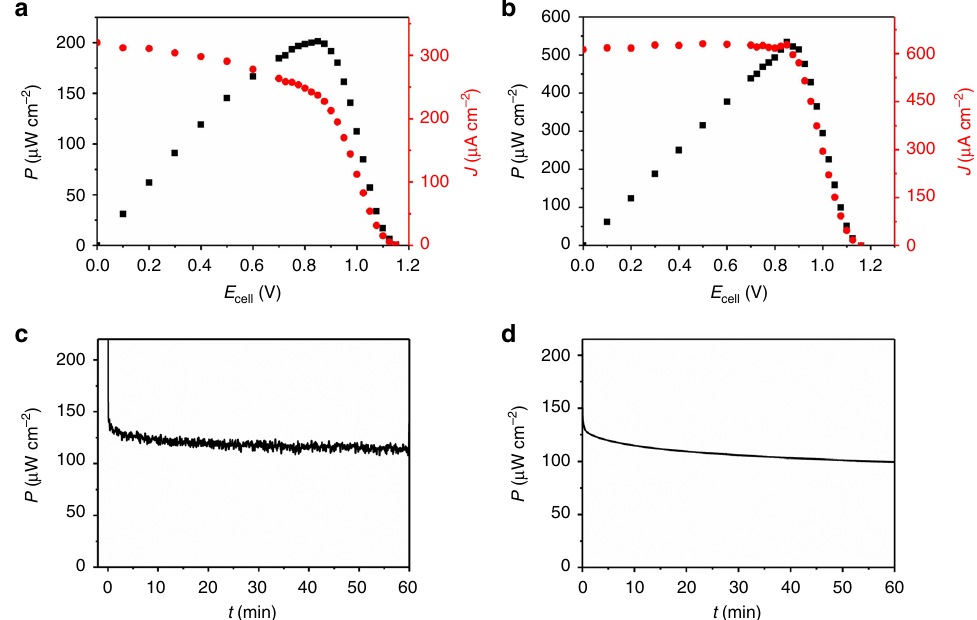
Fig. 5 Characterization of the hydrogen/glucose biofuel cell. Performance ( a , b ) and stability ( c , d ) of the H 2 /glucose(H 2 O 2 )-powered hydrogenase (H 2 ase)/ horseradish peroxidase (HRP)-based biofuel cells in 0.1 M phosphate buffer (pH 7.4) and in a two-compartment cell with the polymer double- layer bioanode (P(N 3 MA-BA-GMA)-vio/H 2 ase//P(SS-GMA-BA)/Py 2 Ox/CAT) and the Py 2 Ox/HRP/CNT/CMF-carbon cloth biocathode. a : H 2 ase = Dv MF-[NiFe], 1 mM glucose in both compartments; OCV = 1.15 V; J = 240 µ A cm − 2 and P max = 200 µ W cm − 2 at 0.85 V. b H 2 ase = Dv H-[NiFeSe], 3 mM glucose in both compartments. OCV = 1.15 V; J = 630 µ A cm − 2 and P max = 530 µ W cm − 2 at 0.85 V. c , d Operational stability at a constant load of 0.8 V of the Dv MF-[NiFe] ( c ) and the Dv H-[NiFeSe] ( d ) based BFC; 3 mM glucose was used in the bioanode and the biocathode compartment. a – d Bioanode compartment = 97% H 2 /3% Ar and biocathode compartment = 50% O 2 /50% Ar. J and P were referenced to the geometrical surface are of the